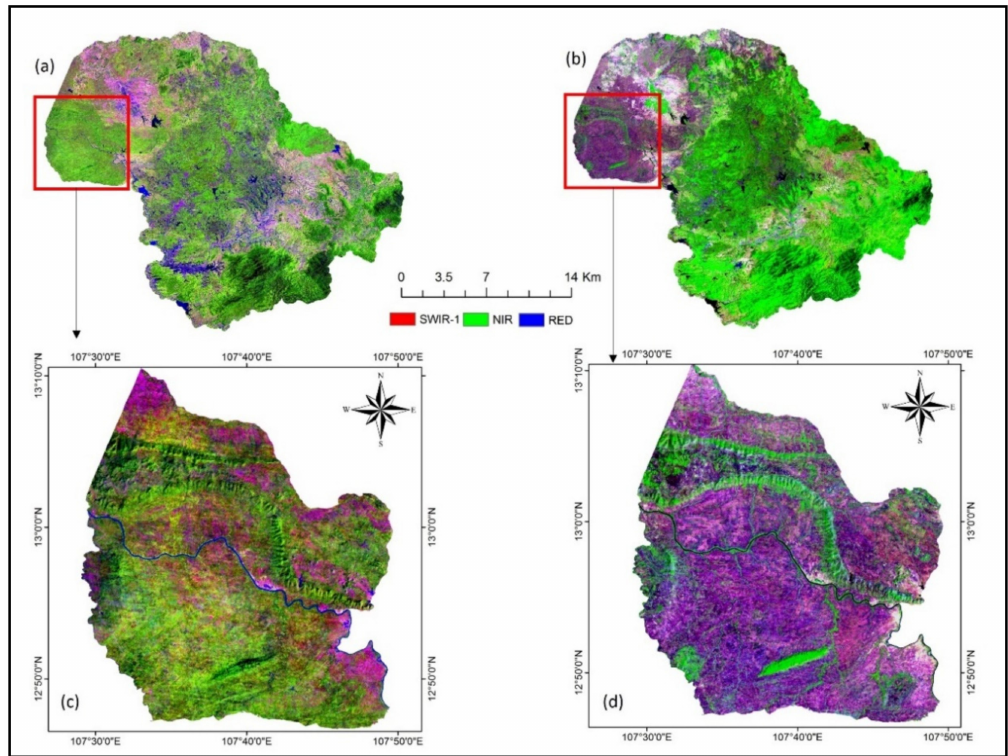
Figure 2. Landsat 8 cloud-free composite images in the rainy ( a , c ) and dry ( b , d ) seasons in Yok Don National Park.